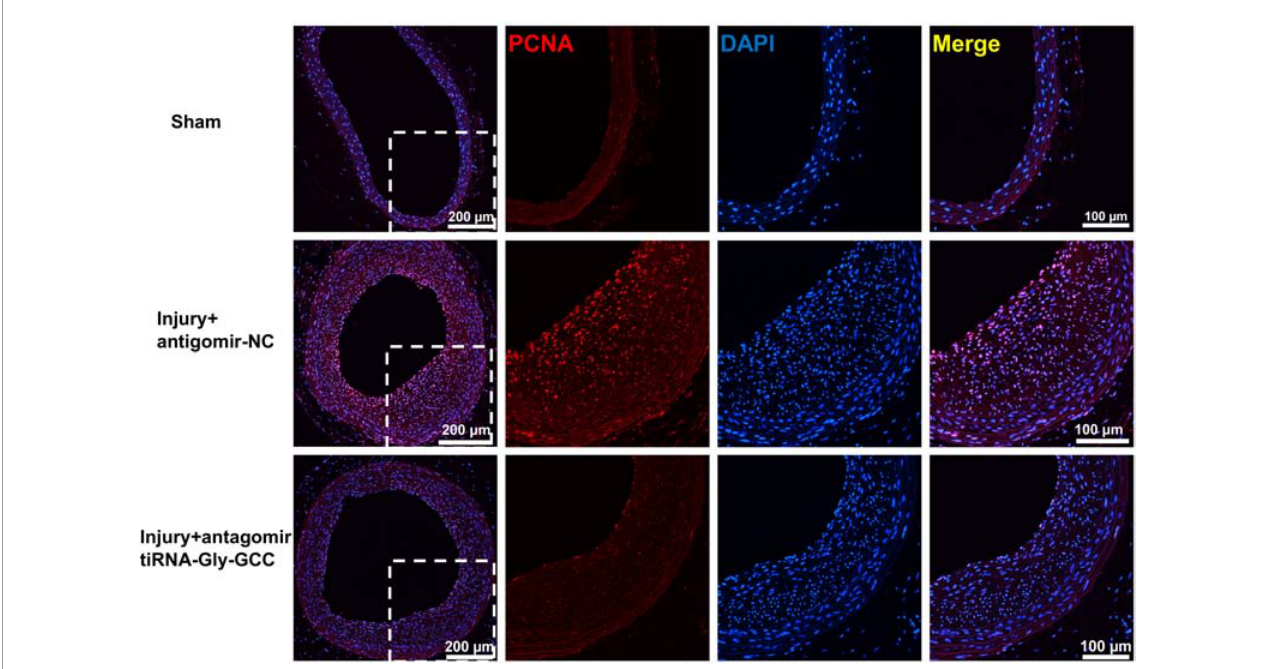
FIGURE8 Inhibition of tiRNA-Gly-GCC reduced VSMC proliferation in vivo . Immunofluorescence staining demonstrated PCNA (red) and DAPI (blue) expression and localization in the sham group and injured arteries treated with antagomir NC or antagomir-tiRNA-Gly-GCC for 14 days, from four independent experiments. Scale bar, 200, 100 µ